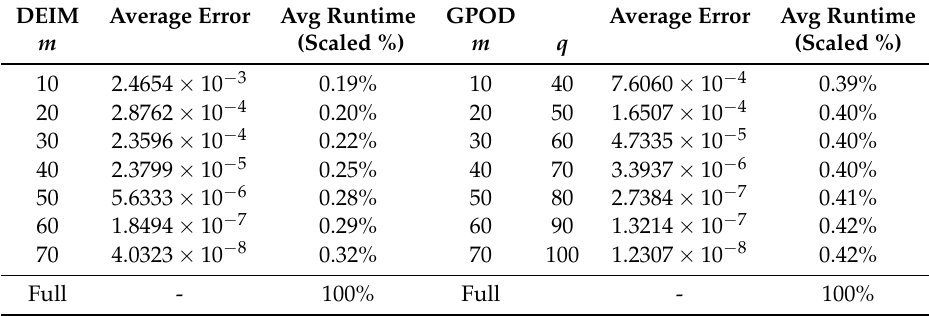
Table 5. [Test 2] Average runtime and average error of the POD-DEIM and POD-GPOD reduced systems with various parameter values and POD basis with dimension k = 50.